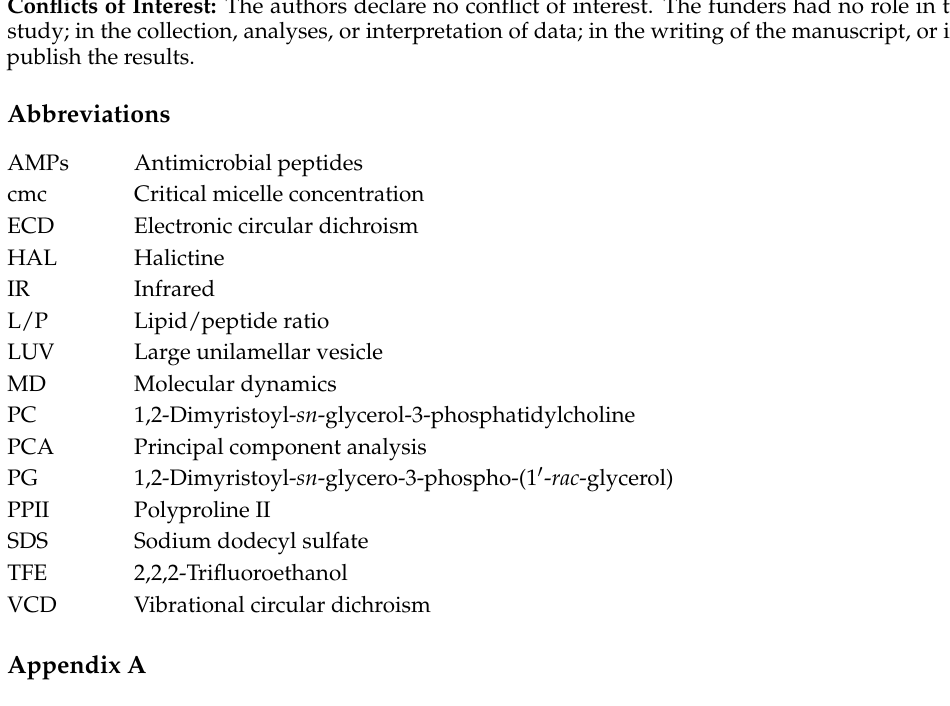
Table A1. Helical fraction for HAL-1 and its analogs in aqueous solution and in the presence of TFE (concentration expressed in volume percent ( v / v )) and SDS (in mM) calculated using a two-state model from ECD spectra [30,61].